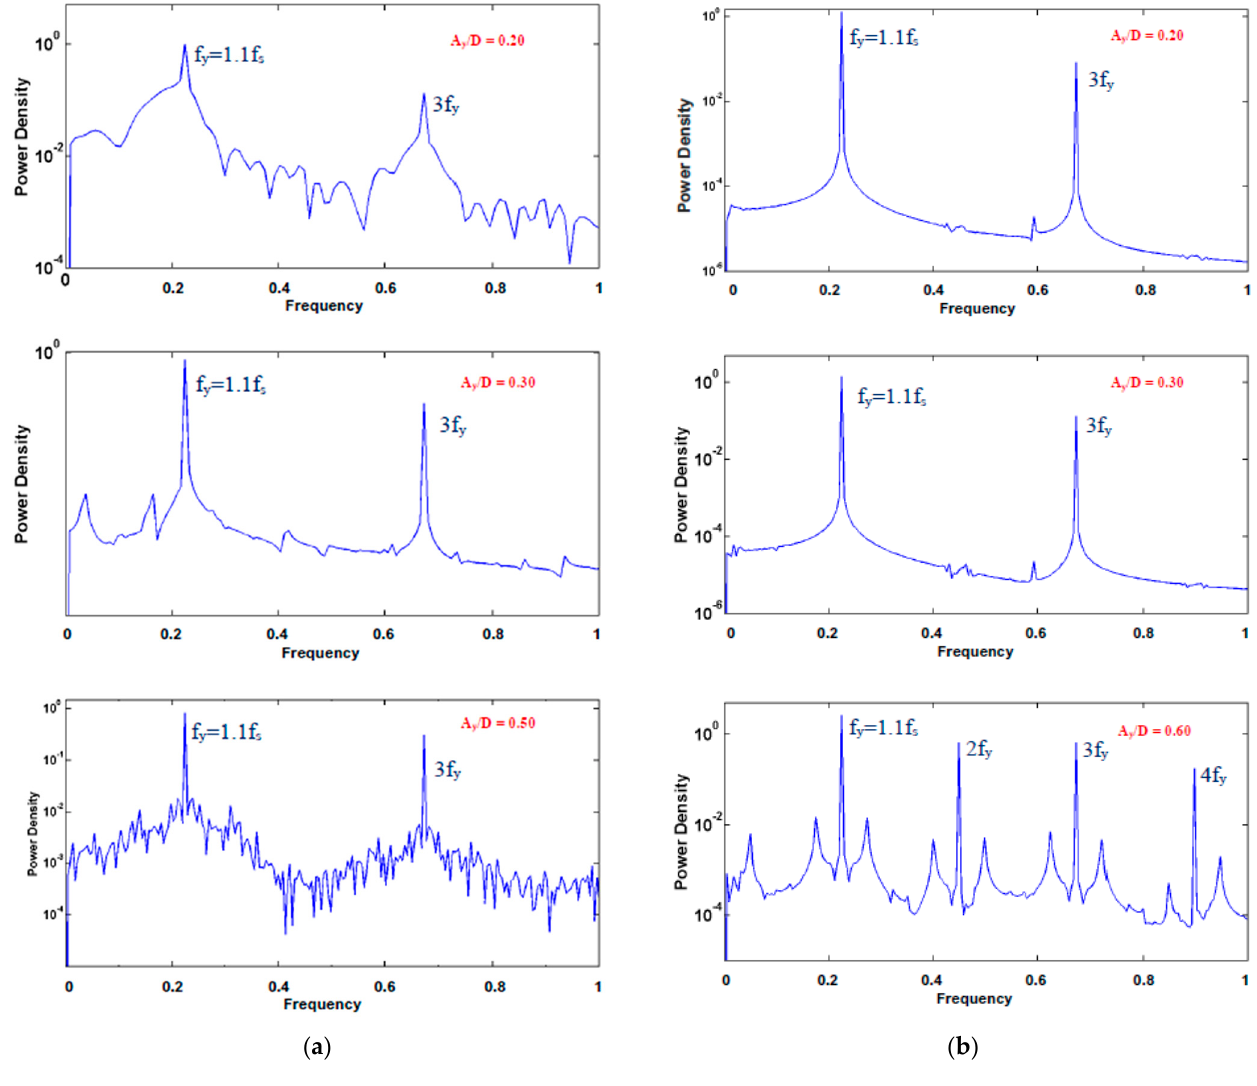
Figure 8. Spectra of the lift force coefficient for F = 1.1: ( a ) counter-clockwise cylinder oscillation, ( b ) clockwise cylinder oscillation.